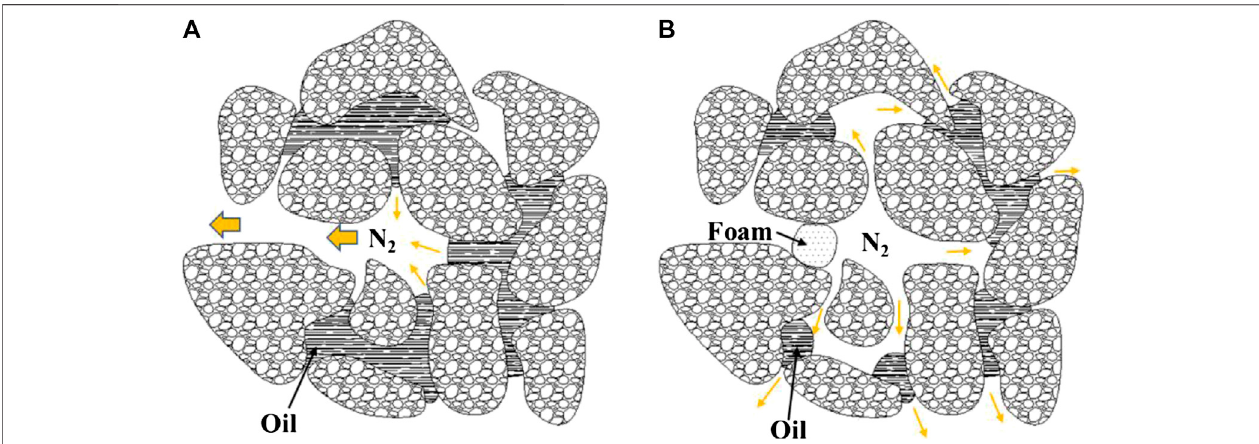
FIGURE 17 | Foam plugging